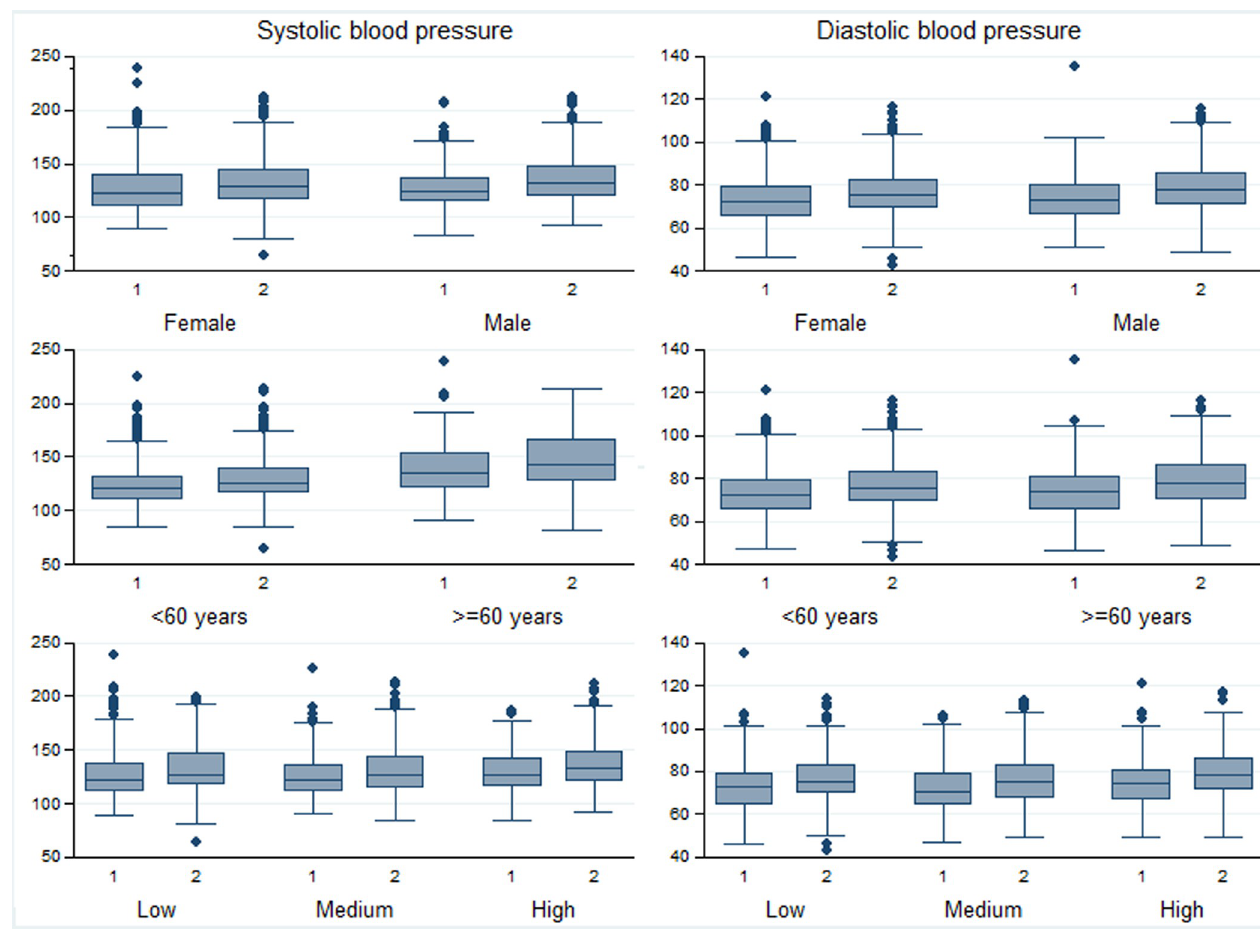
Fig 2. Systolic and diastolic blood pressure, by gender, age and wealth